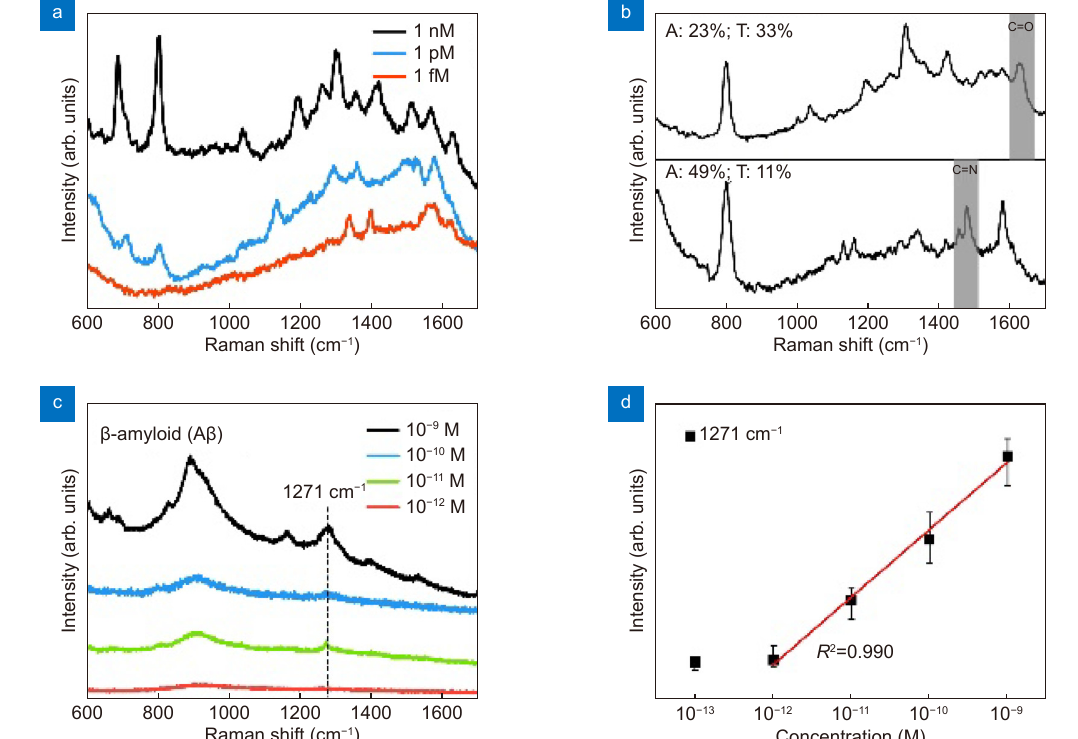
Fig. 5 | ( a ) Raman spectra for DNA sequences at different concentrations measured by the LI-SERS method. ( b ) Raman spectra for two DNA se- quences (10 fM) consisting of different ratios of bases. The C=O stretching at 1640 cm –1 and the C=N stretching at 1474 cm –1 are highlighted with gray bars. ( c ) Raman spectra of Aβ (29-40) at different concentrations as measured by the LI-SERS method. ( d ) Variation of Raman intensity, which is averages from ten measurements at each concentration at 1271 cm –1 with the error less than ~10% as a function of concentration. The red line is the linear fitting of Aβ (29–40) concentrations and Raman intensity at 1271 cm –1